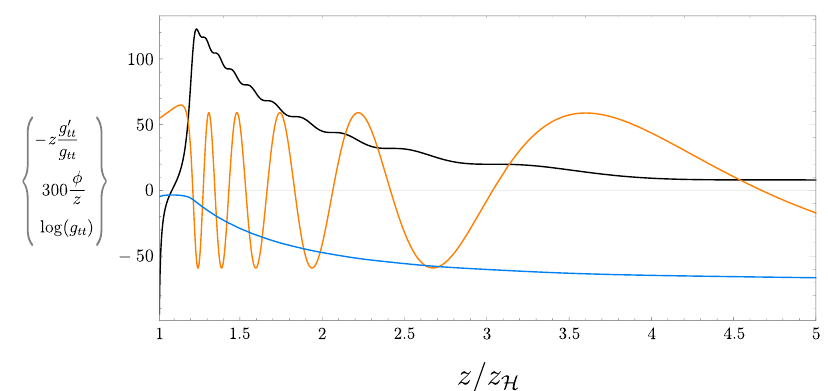
Figure 2: The shaded orange region of Fig. 1. The same colors have been used, but 300 φ/ z is plotted instead of z φ (cid:48) to highlight the oscillations and their amplitude. The imprint of the oscillations on the metric are clearly visible. Here q = 1, m 2 = − 2 = and T / T c